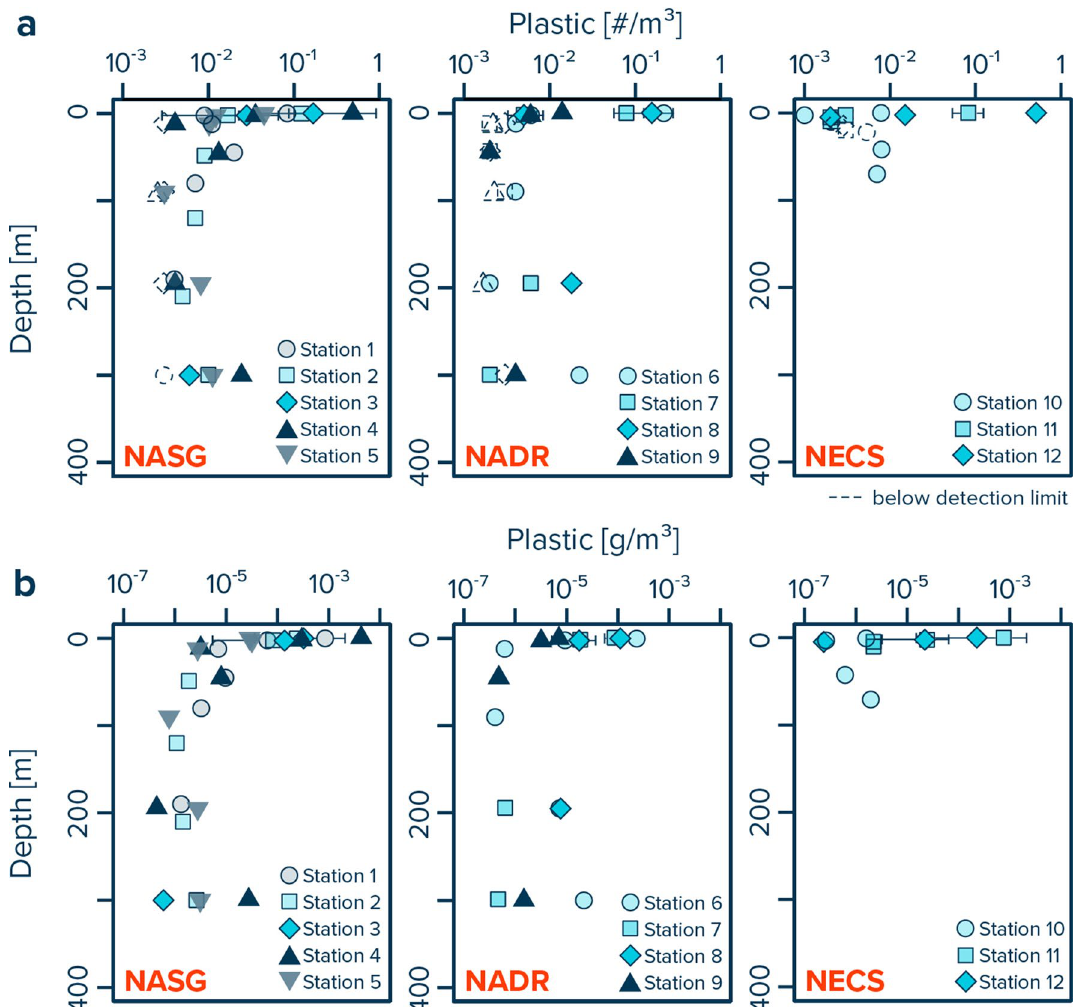
Figure 2. Water column profiles of ( a ) numerical and ( b ) mass concentrations of plastic particles between 0.05 and 5 cm in size. Data collected with Manta trawls are presented for the upper 0.15 m (net opening) of the ocean surface, and as values corrected for wind-induced mixing in the upper 5 m of water column, with average concentrations and whisker extending to the smallest and largest concentrations measured. Dashed symbols represent the detection limit for multinet samples in which no plastic fragments were found. NASG North Atlantic Subtropical Gyre, NADR North Atlantic Drift Region, NECS Northeast Atlantic Continental